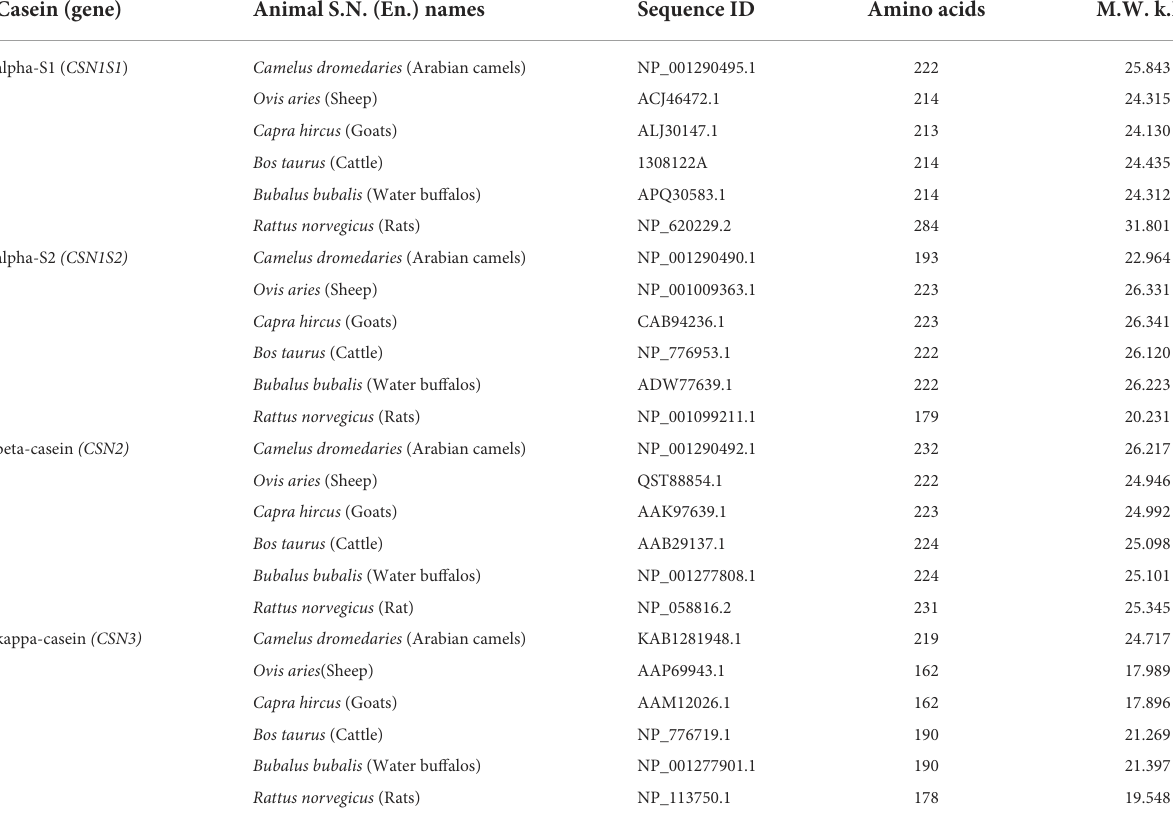
TABLE 1 Animal S.N. (En.) names, sequence ID, amino acids, and molecular weight of caseins in five dairy animals. Casein